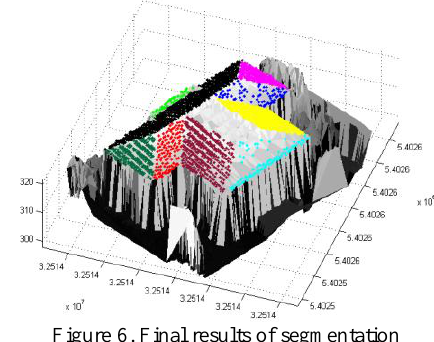
Figure 6. Final results of